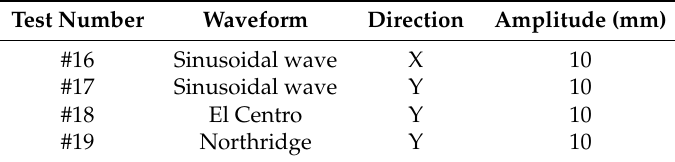
Table 4. Experiment scheme in night test.